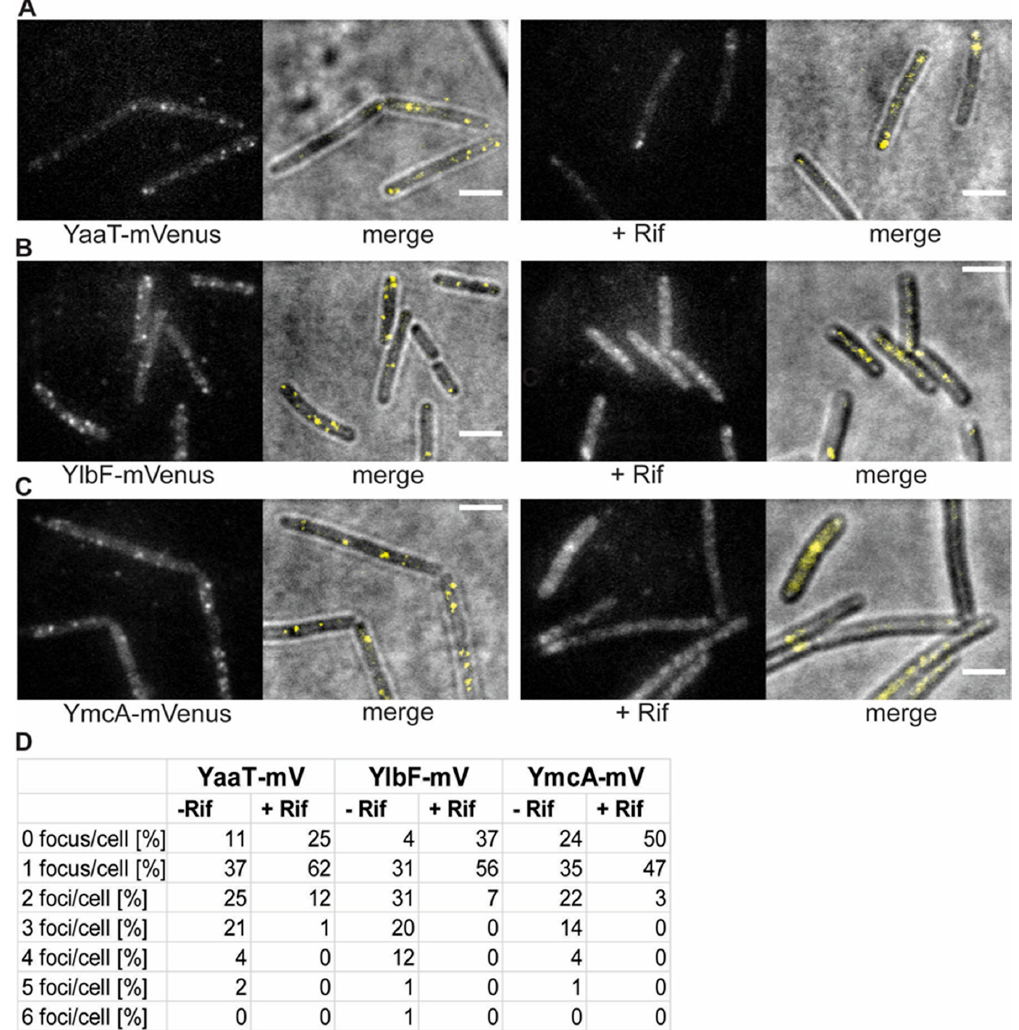
Figure 2. Changes in the localization patterns of Y-complex proteins during the exponential growth phase and in phase response to transcription arrest, by treatment with rifampicin for 30 min (“+ Rif”). ( A – C ): Localization by slim-field illumination. ( A – C ) Panels show the localization of the three different Y-complex proteins expressed from the native locus. Merge displays overlay of bright field and fluorescence. Scale bars 2 µm. ( D ): Percentage of the number of foci in cells with fluorescent signal before and after treatment with rifampicin.